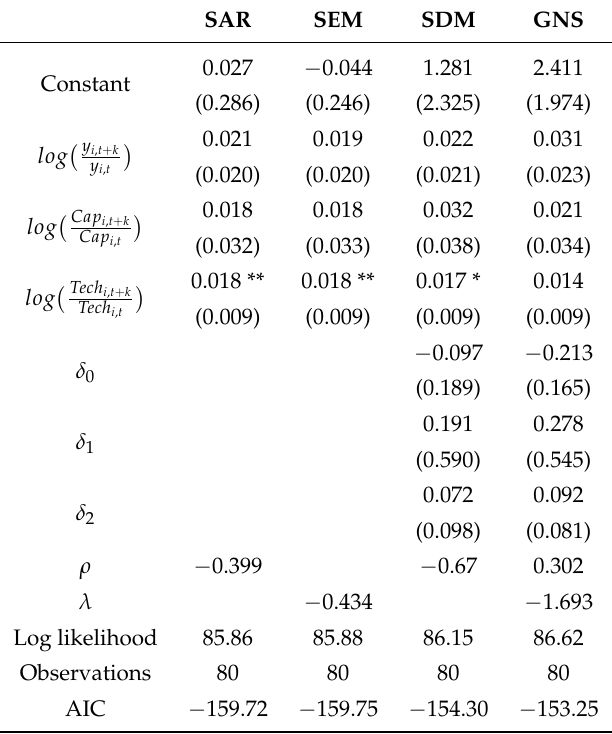
Table 6. Conditional β -convergence models for 2014-2017. The weight matrix is specialization